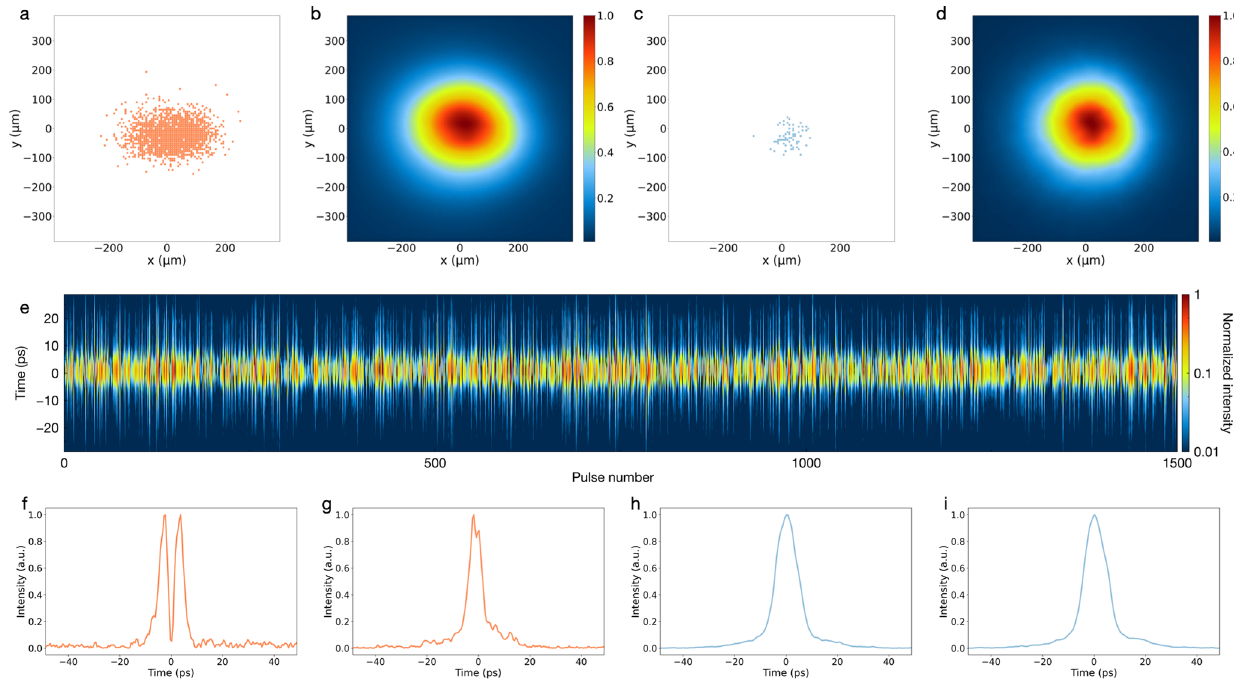
Fig. 2 Spatial and temporal measurements. a Position of the maximum intensity for each pulse in the dataset containing streak camera images. b Average beam pro fi le calculated from all the pulses in the dataset. c Position of the maximum intensity for each pulse with rogue event. d Average beam pro fi le calculated from the pulses with rogue events. e Stack of 1500 noise-like pulse shapes presented with a logarithmic intensity scale (normalized to maximum of the dataset). f , g Normalized example temporal shapes of the pulses with intensities less than the rogue wave threshold. h , i Normalized example temporal shapes of the pulses with rogue